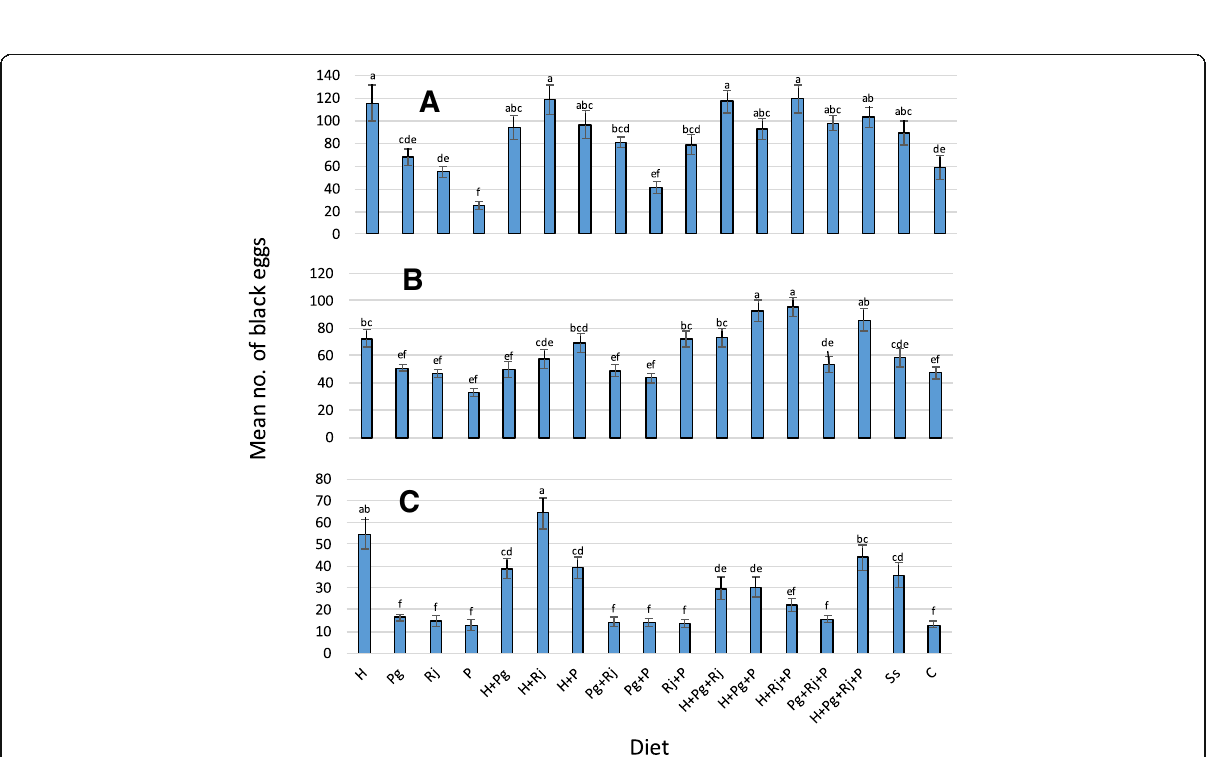
Fig. 2 Mean number of eggs laid by females of a T. evanescens , b T . bourarachae , and c T. cacoeciae supplied with different diets and the